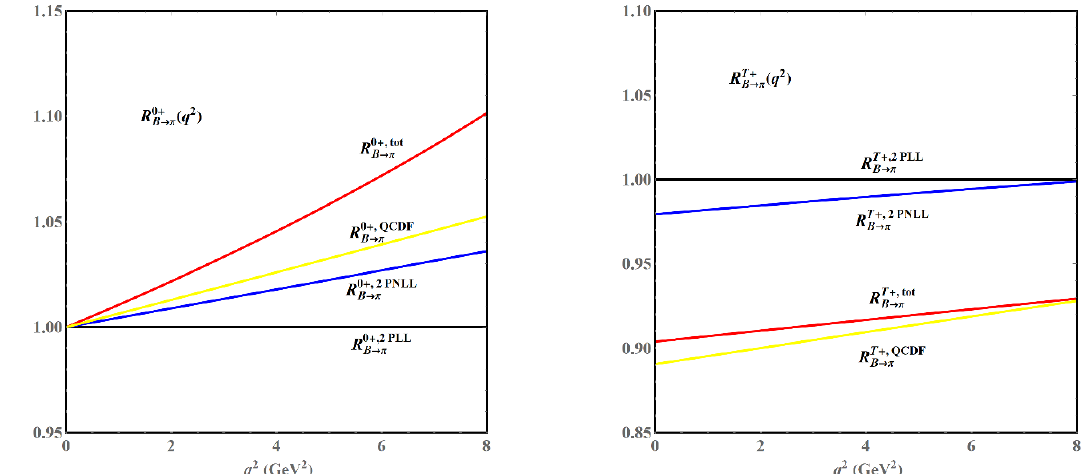
Figure 5 . The large-recoil symmetry breaking e(cid:11)ects of B ! (cid:25) form factors computed from the LCSR approach at LL accuracy ( R i + ; 2PLL the QCD factorization approach ( R i + ; QCDF ( i = 0 ; T ) with the higher-twist B -meson LCDA corrections at tree level are represented by the red curves.